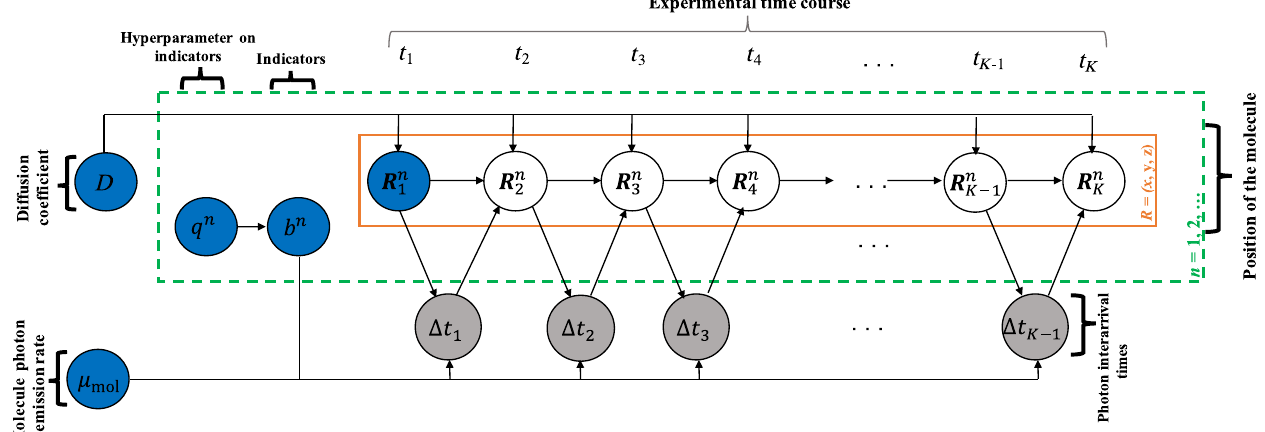
FIG. 3. BNP formulation used for the analysis of photon arrival traces. Molecules, indexed n ¼ 1 ; 2 ; … , evolve over the experimental ; y n ; z n time course which is indexed by k ¼ 1 ; 2 ; … ; K . Here, R n ¼ ð x n Þ indicates the location of molecule n at time t k . During the k k k k experiment, only a single observation (interarrival time) Δ t is recorded, thereby combining photon emissions from every molecule and k the background. The diffusion coefficient D determines the evolution of the molecular positions which influence the photon emission rates and eventually the recorded Δ t . The indicator variables b n are introduced to infer the unknown molecule population size. In the k graphical model, the measured data are highlighted by gray shaded circles and the model variables, which require priors, are designated by blue